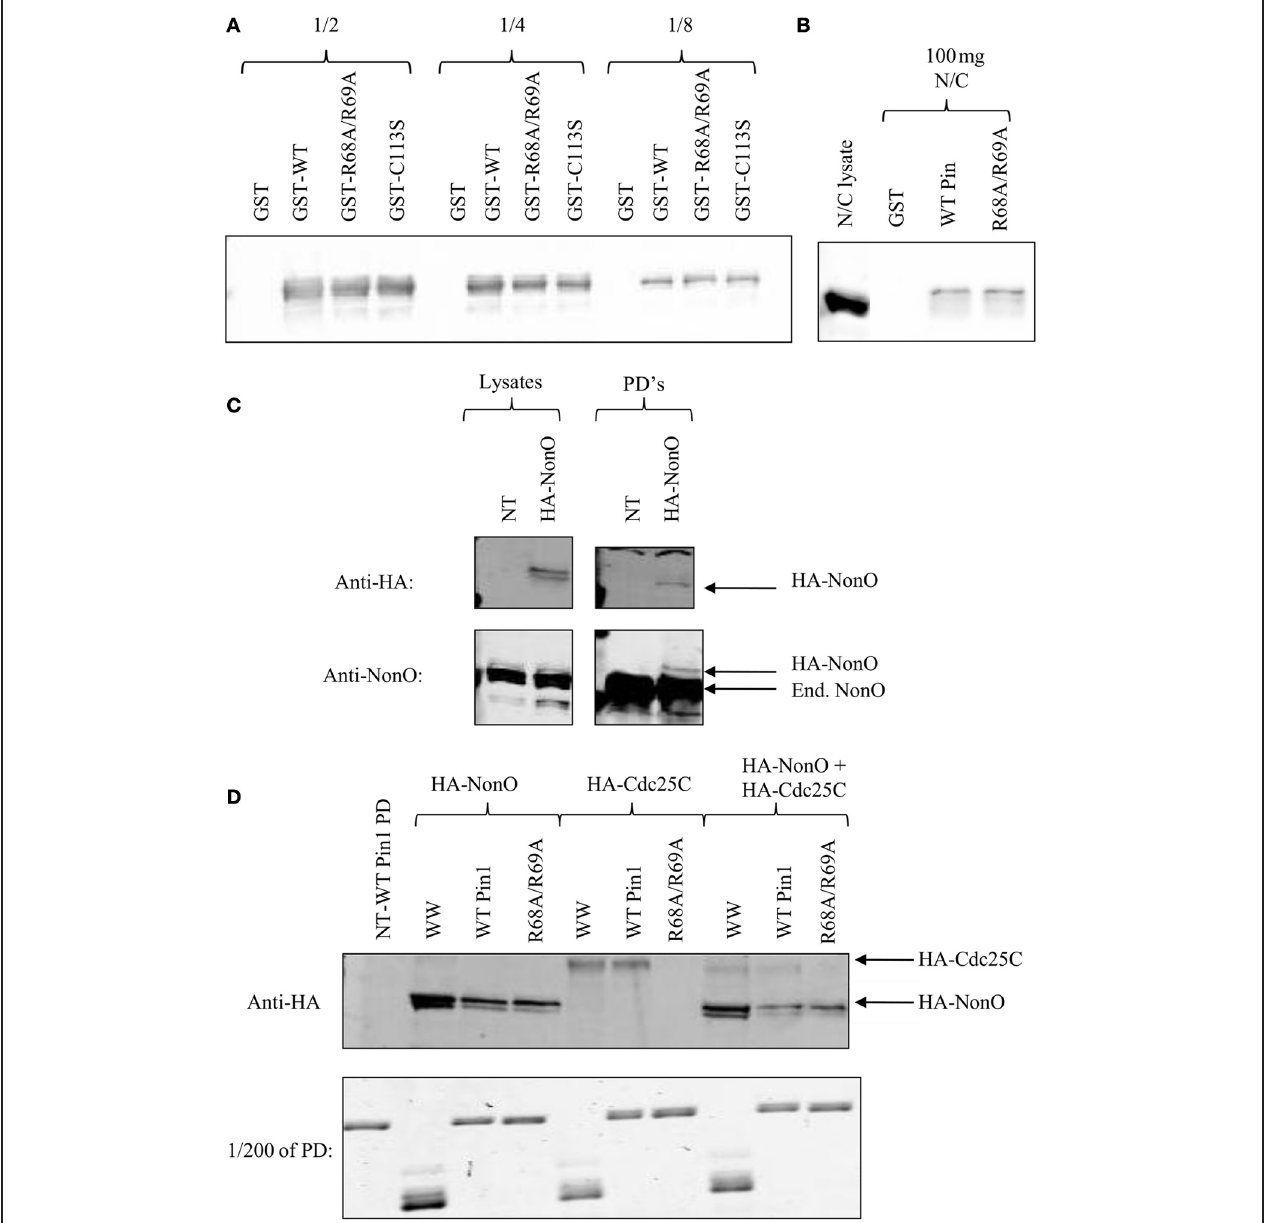
Coomassie Blue. (C) HeLa cells were either transfected with HA-NonO or left untransfected (NT). Lysates were used in GST pull-downs (PD’s) as above and immunoblotted with the indicated antibody. Endogenous NonO is indicated with End. (D) HeLa cells were transfected with HA-NonO or HA-Cdc25C or left untransfected (NT). Lysates were used in pull-downs (PD) as above and transfected proteins were detected with anti-HA. For the combined sample, 1mg of HA-NonO lysate was mixed with 1mg of HA-Cdc25C